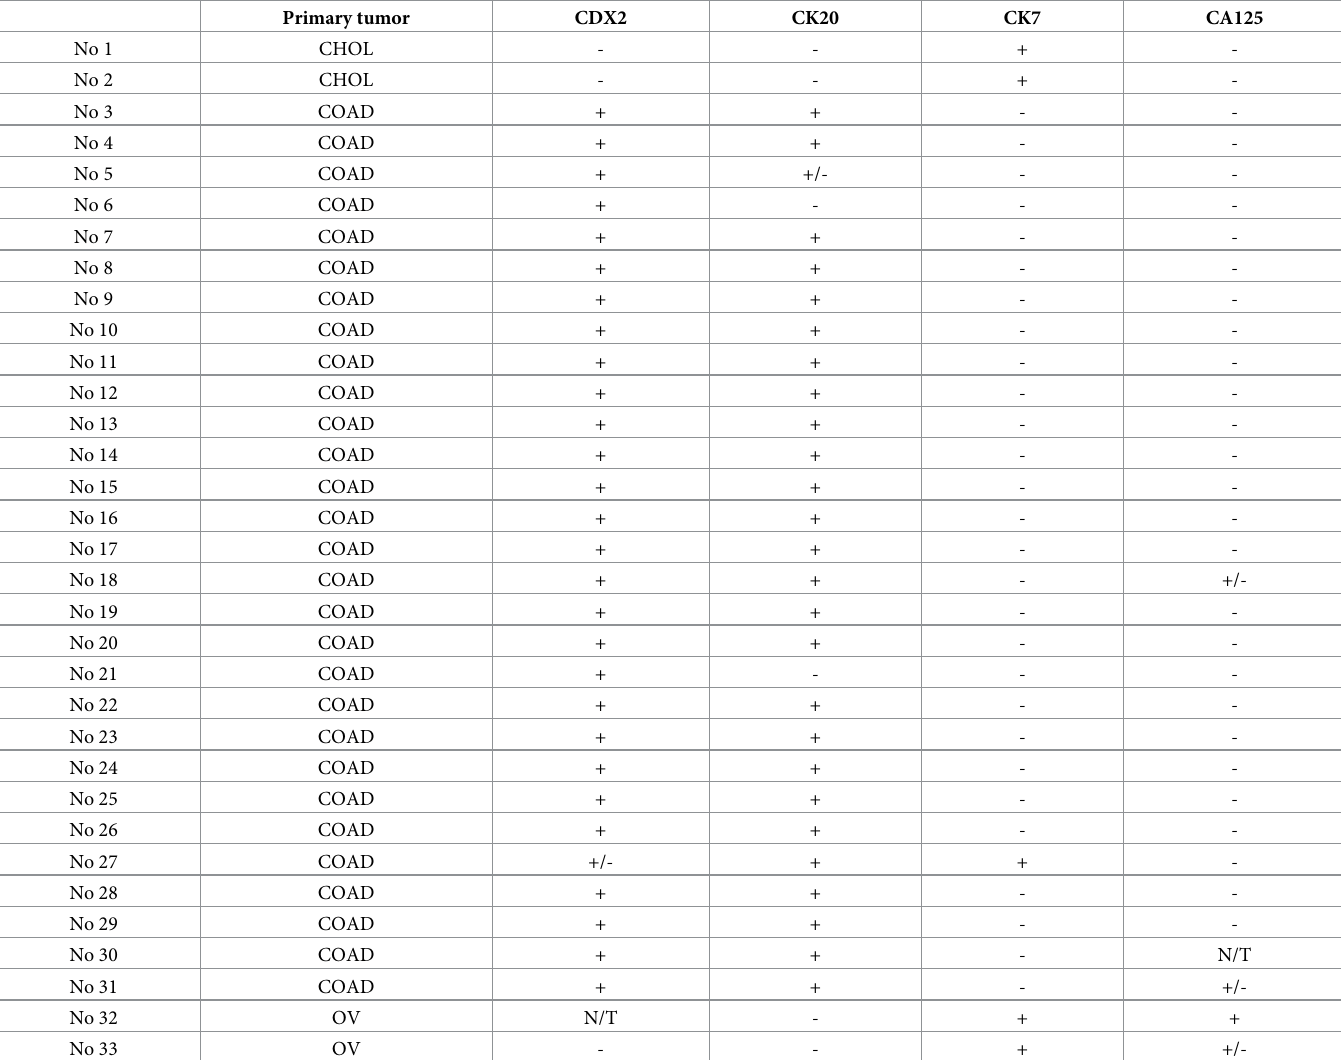
Table 3. CDX2, CK20, CK7, and CA125 immunostaining in the test